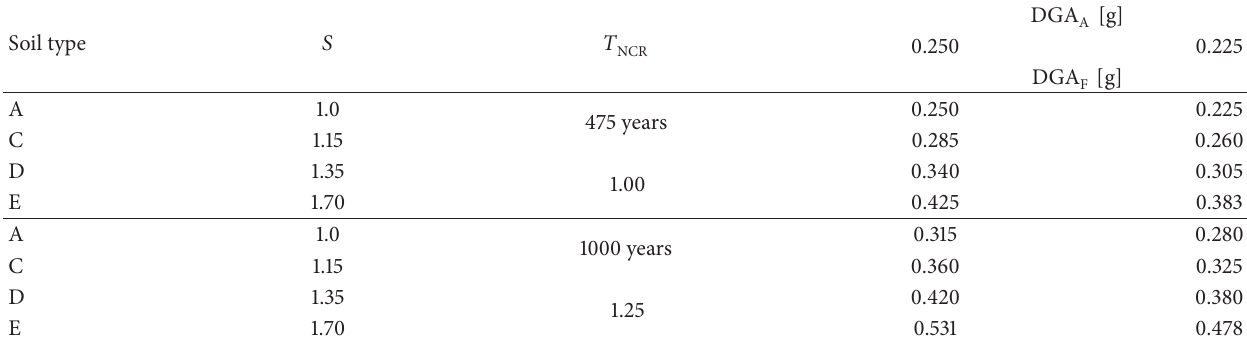
Table 5: Final design ground acceleration values for each soil type in Breginjski